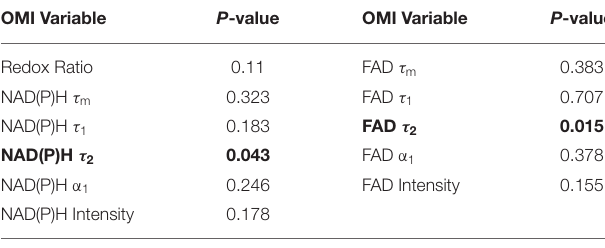
TABLE 1 | P -values from non-parametric regression between treatment condition and Moran’s I in xenografts.